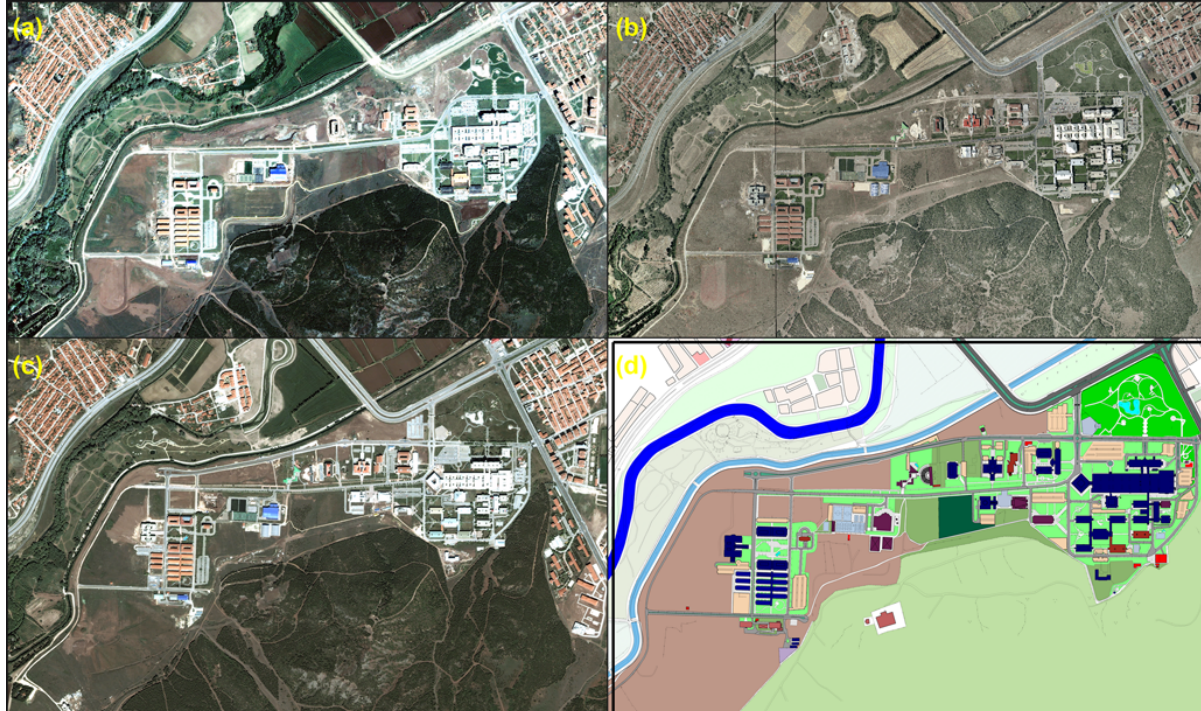
Fig. 2. General view of the campus area via aerial photos and layout plan: (a) Year 2002, (b) Year 2006, (c) Year 2009 and (d) Year 2010.